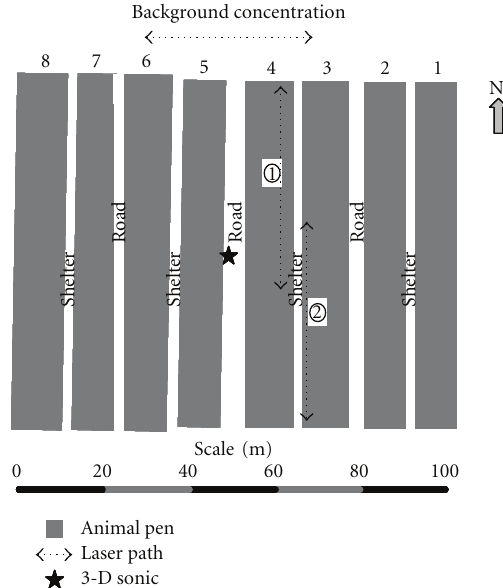
Figure 1: Overview of the feedlot and an illustration of the loca- tions of instruments. Laser-path labeled period and the path labeled and fall periods.